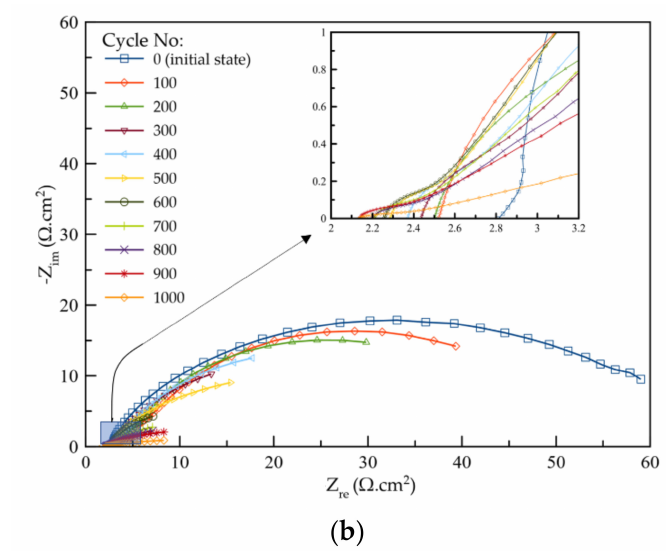
Figure 5. ( a ) Galvanostatic charge / discharge profiles of the batteries, using di ff erent electrolytes, having a circulation rate of 100 mL / min and repeated cycling discharge of 50 mA / cm 2 to 5 mAh and charge of − 30 mA / cm 2 to 5 mAh. ( b ) Nyquist plots of the cycling impact on the impedance of a cell containing 450 ppm KPS additive to the KOH / ZnO electrolyte at initial state and after every 100 charge / discharge cycles until 1000th cycle, in the frequency range from 100 kHz to 0.1 Hz, having an alternate current amplitude of 10 mV around the